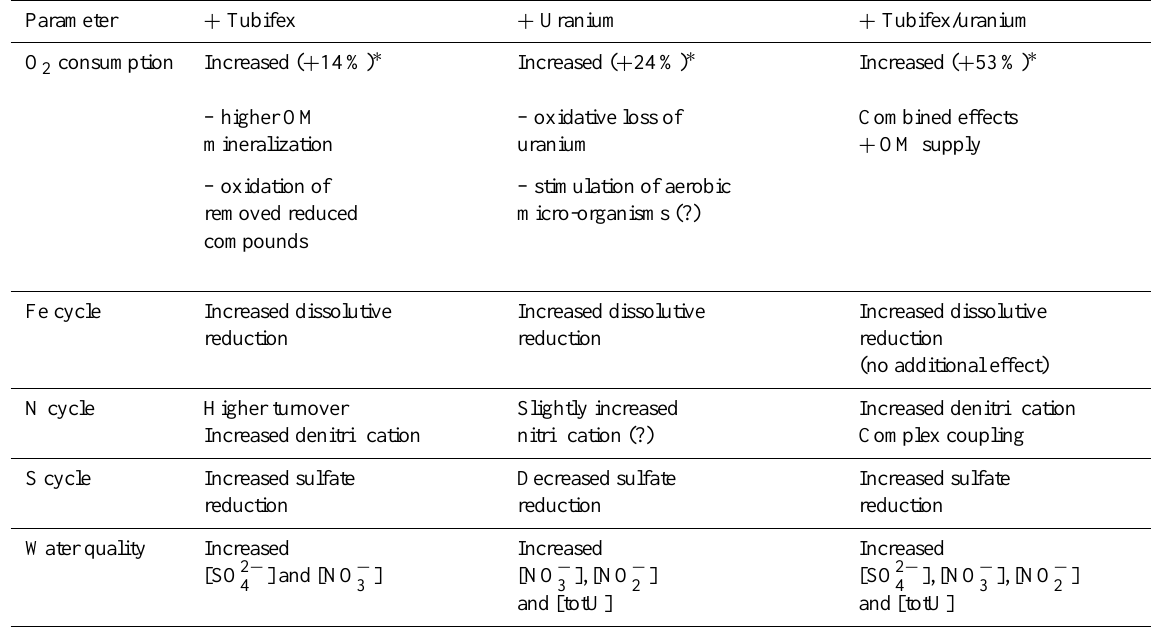
Table 2. Effects of T. tubifex and uranium on sediment biogeochemistry. Parameter +